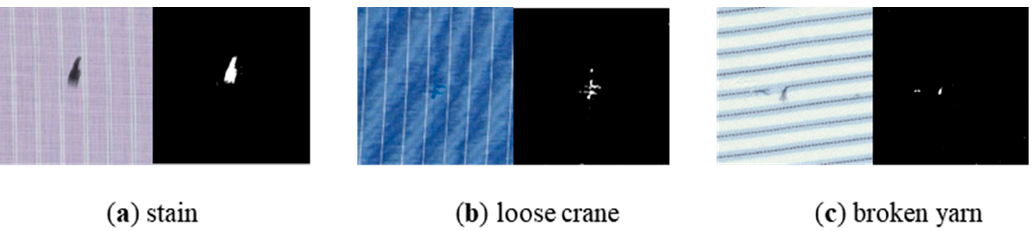
Figure 14. Striped fabric defect of detection results.